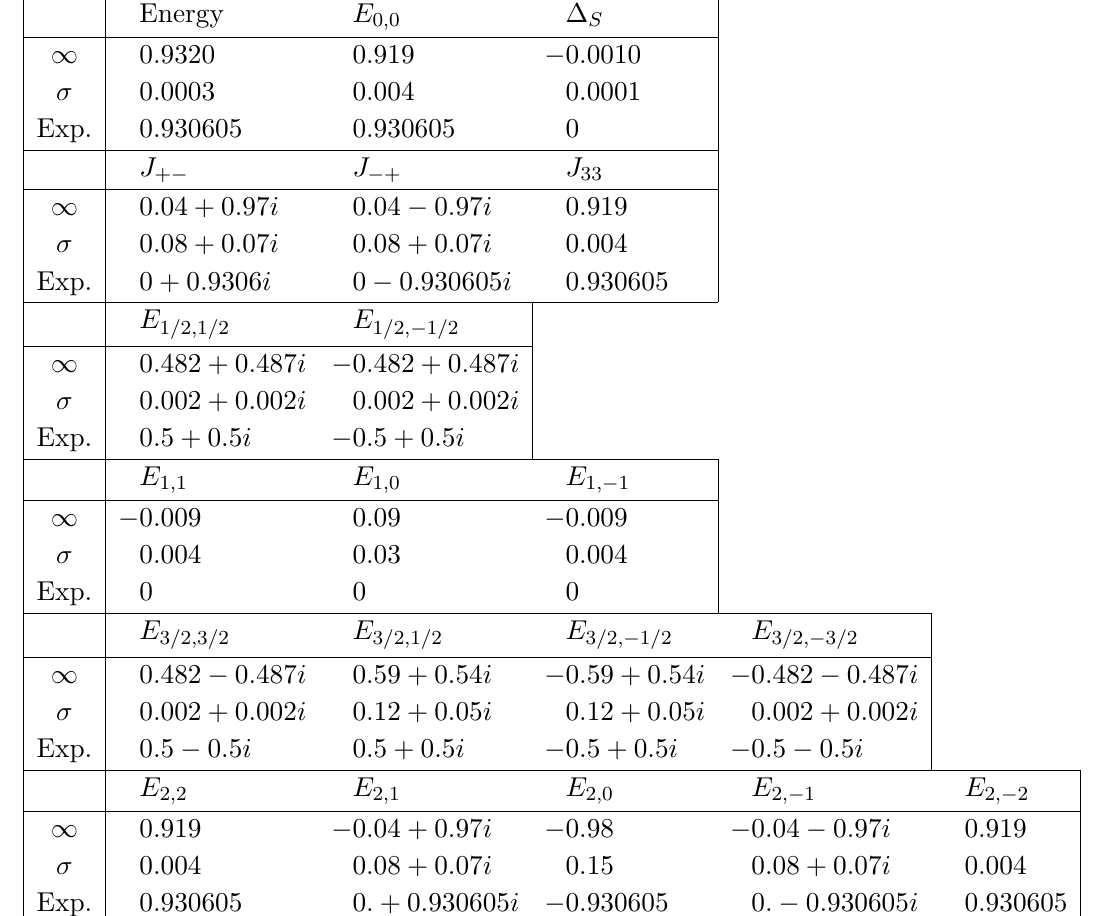
boundary state with 2